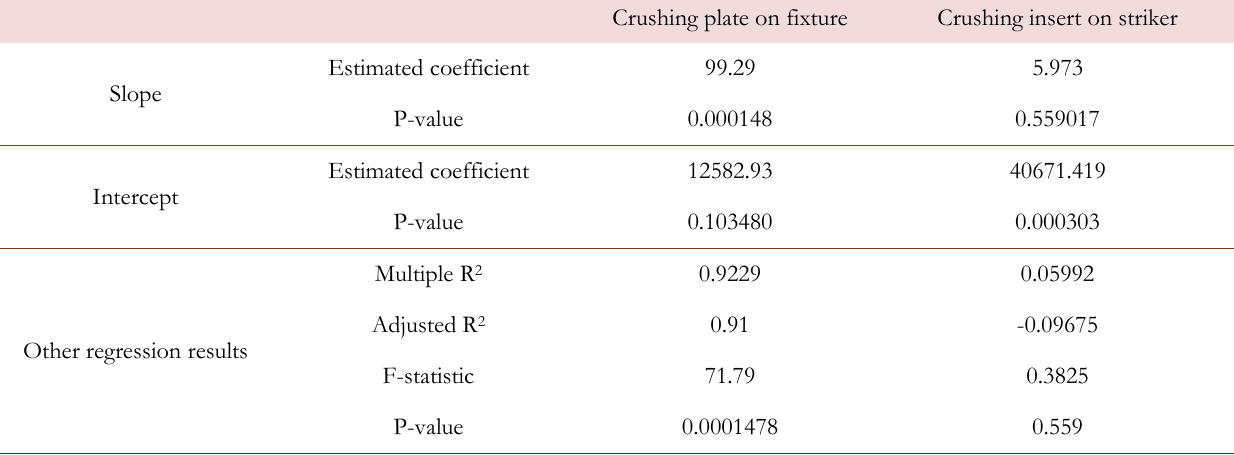
Table 3: Regression results for the two linear models plotted in Fig. 10, where the peak force is expressed as a function of the impact